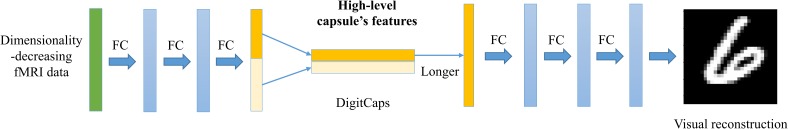
The flow of visual reconstruction. The former half part trained at the second training stage is responsible for the mapping from dimensionality-decreasing fMRI data to the two high-level capsule’s features, the latter part (reconstruction part) trained at the first stage is responsible for the reconstruction based on the longer capsule. In this way, the high-level capsule’s features are used to bridge between fMRI data and image stimuli.